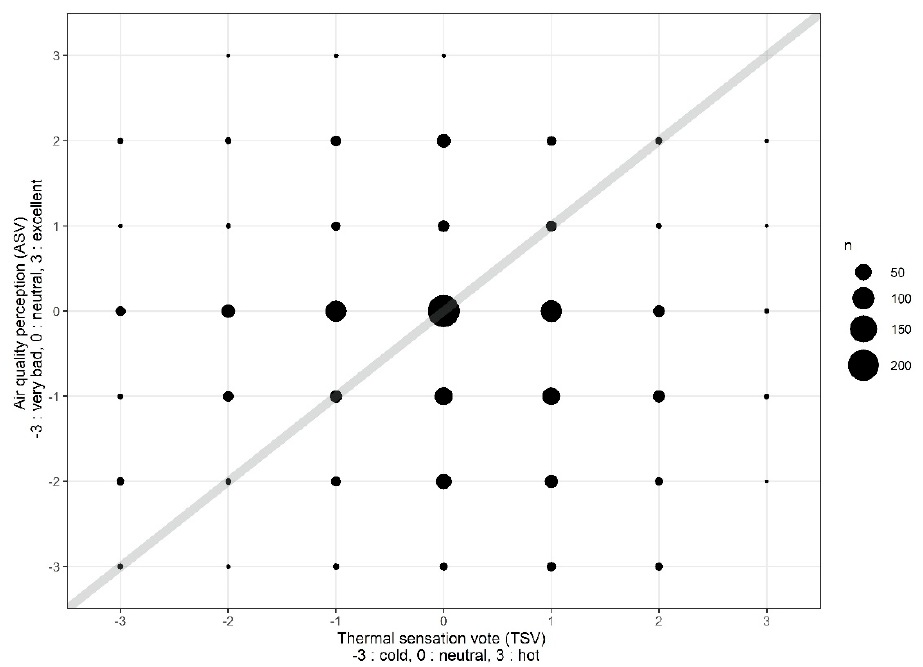
Figure 7. Comparison of agreement between thermal and air quality perception vote results for Stage 2 (the number of responses n is proportional to the area of circles).